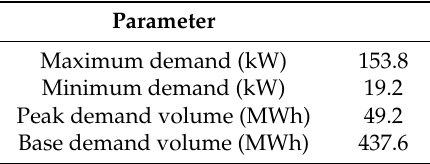
Table 3. Household load characteristics.